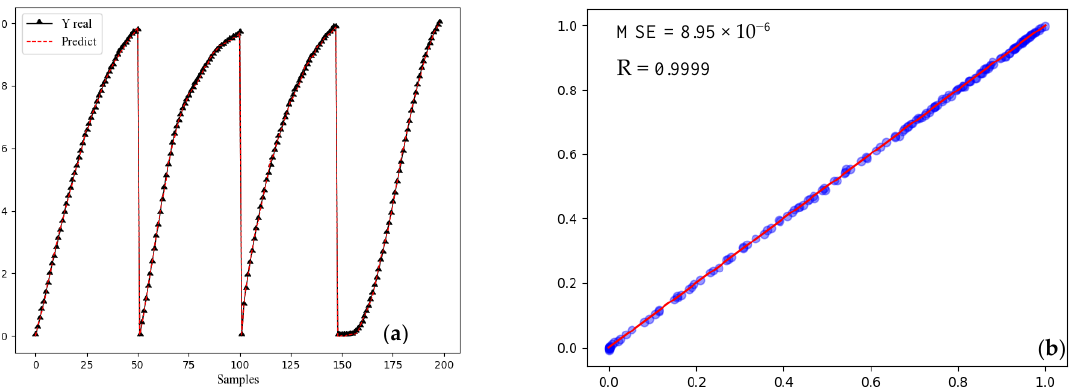
Figure 12. The best network-developed MLP with two hidden layers ( a ) Compare predicted using real data ( b ) strong positive correlation.